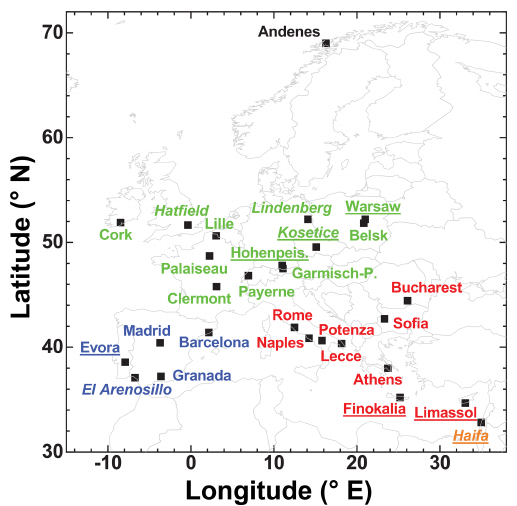
Figure 1. Lidar network of 23 ACTRIS–EARLINET stations and five non-EARLINET sites (in italics). This network observed strato- spheric smoke layers from August 2017 to January 2018. Northern (black), central and western (green), southwestern (blue), southeast- ern European (red), and Israel (orange) lidar sites are distinguished. Polly stations are underlined.